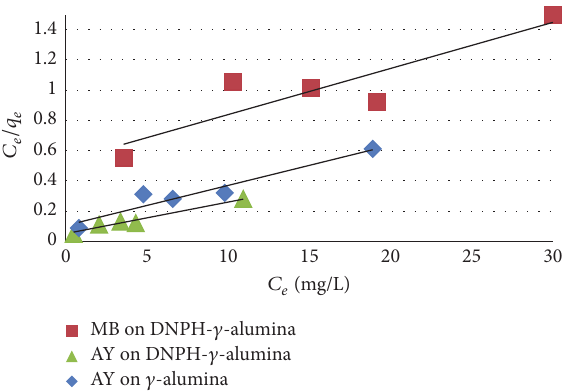
Figure 11: Langmuir isotherm plots for adsorption of AY and MB on 𝛾 -alumina and DNPH- 𝛾 -alumina.